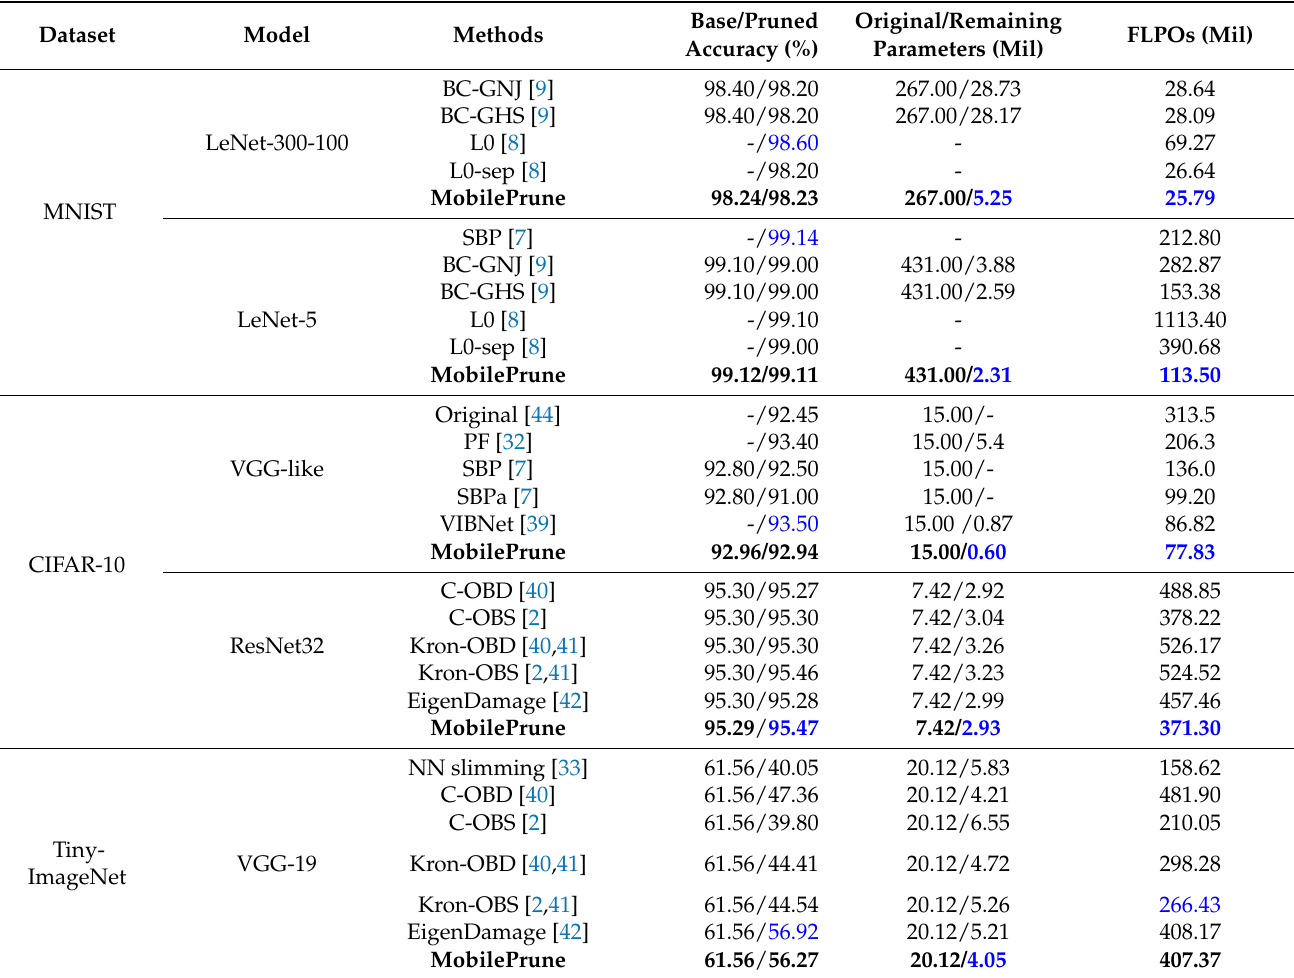
Table 1. Comparison of pruned models with state-of-the-art methods on different datasets – MNIST, CIFAR-10, and Tiny-ImageNet, respectively. (We highlight our MobilePrune results and mark the best performance as blue among different methods for each model in each